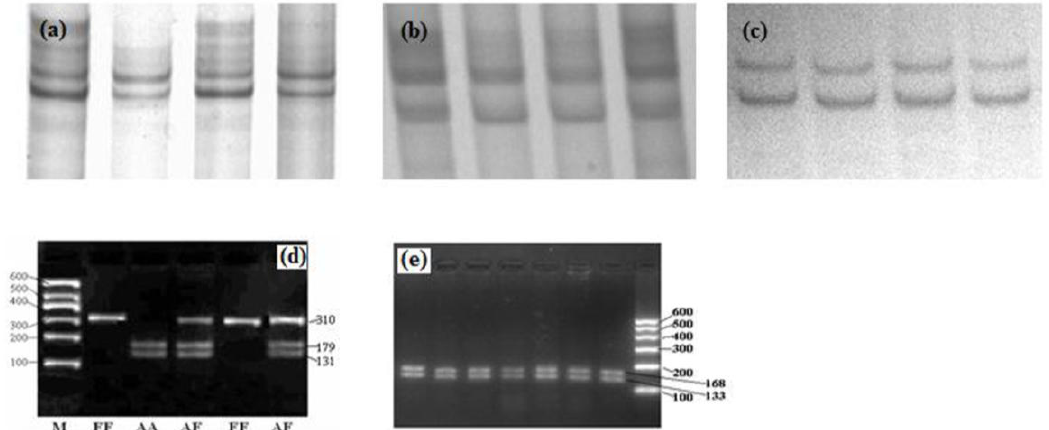
Figure 1. PCR products of five loci analyzed by PCR-SSCP and PCR-RFLP. Figure 1-a, b, c are the PAGE-electrophoresis patterns of PCR-SSCP for L1 (a), L3 (b), L5 (c) locus of CSN1S2 gene, respectively. They all show monopolymorphy. Figure 1-d is the 2.5% agarose gel electrophoresis for Alw26 I digesting PCR products of CSN1S2 L2 locus. Figure 1-e is the 2.5% agarose gel electrophoresis for Nco I digesting PCR products of CSN1S2 L4